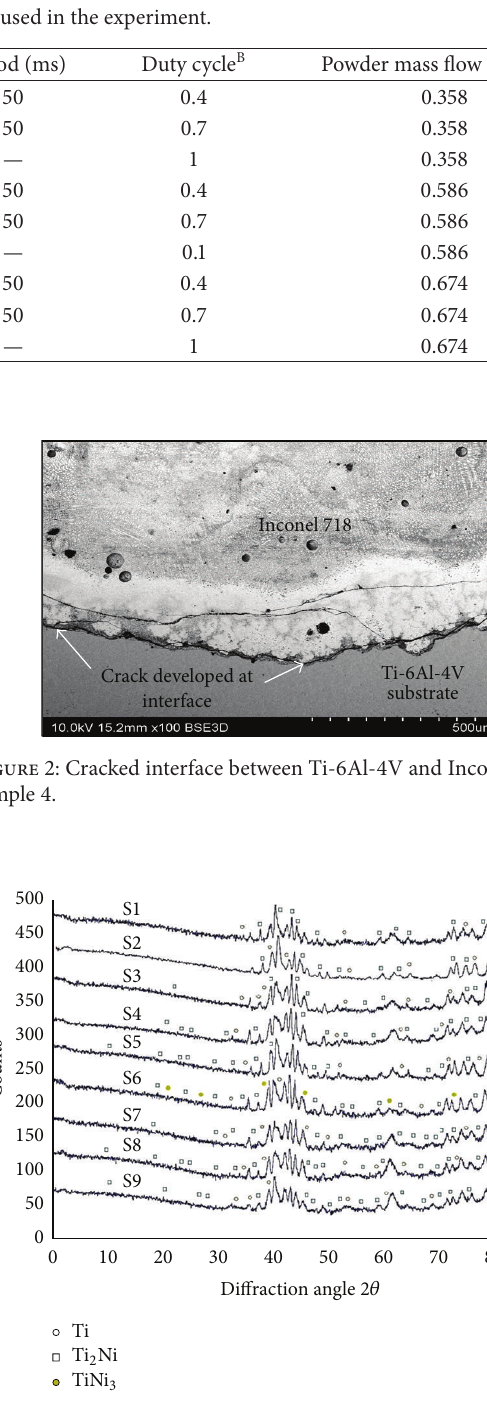
Figure 3: XRD diffraction patterns showing the presence of various phases.